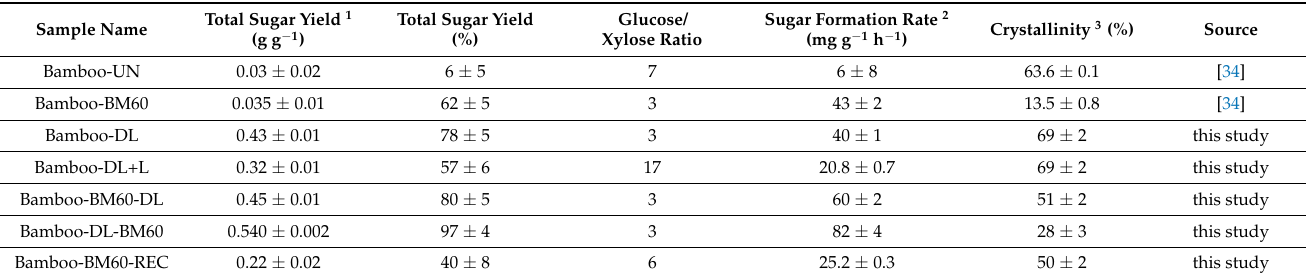
Table 1. Sugar yields and formation rates observed for B. vulgaris treated under different